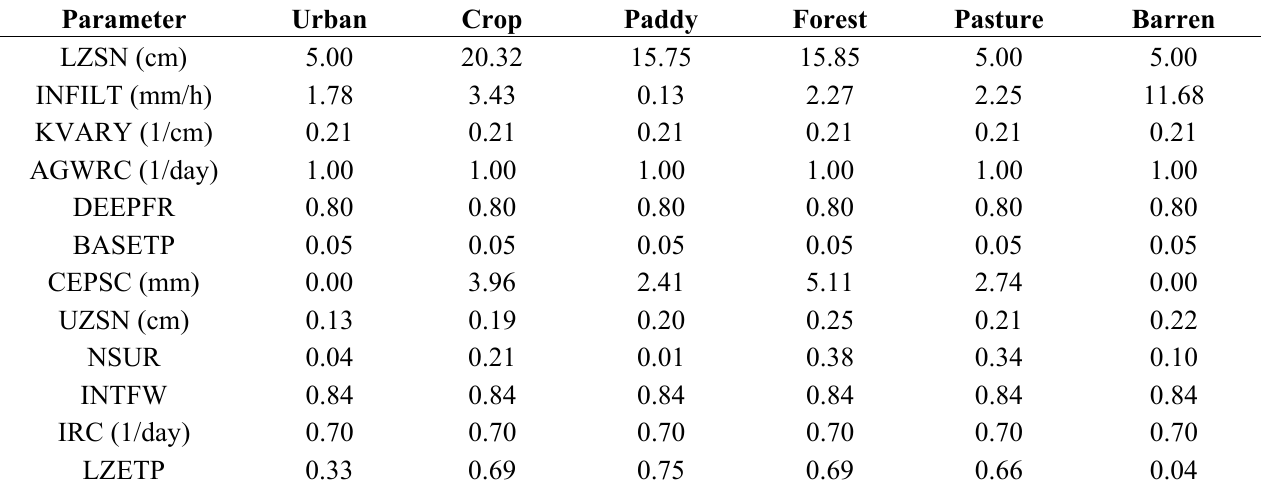
Table 7. Optimized hydrological parameters of HSPF-Paddy model. Parameter Urban Crop Paddy Forest Pasture Barren